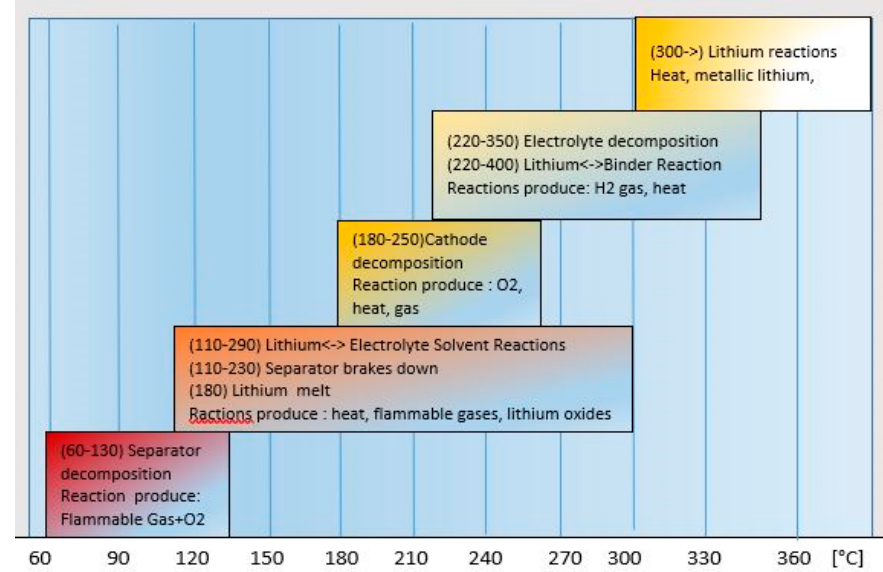
Figure 4. List of changes taking place in the cell as a temperature